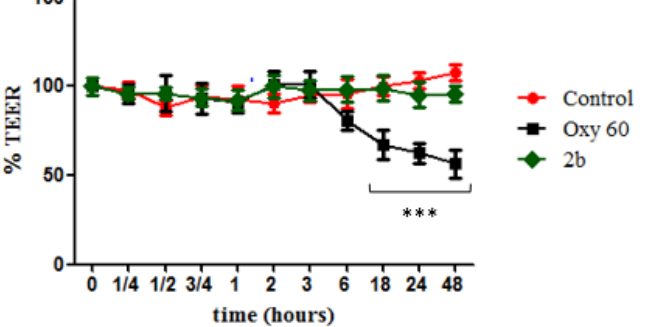
Figure 3. Measurement of cell monolayer permeabilization (transepithelial electrical resistance (TEER)) assay. Caco-2 cell monolayers were incubated with OXY at 60 µ M (black squares) as negative control, derivative 2b at 20 µ M (blue triangles), and Control (red circles) as internal positive control. Statistically significant differences are expressed as follows: *** = p < 0.001 vs. Control. Each value represents the mean ± SD of independent experiments ( n = 3).